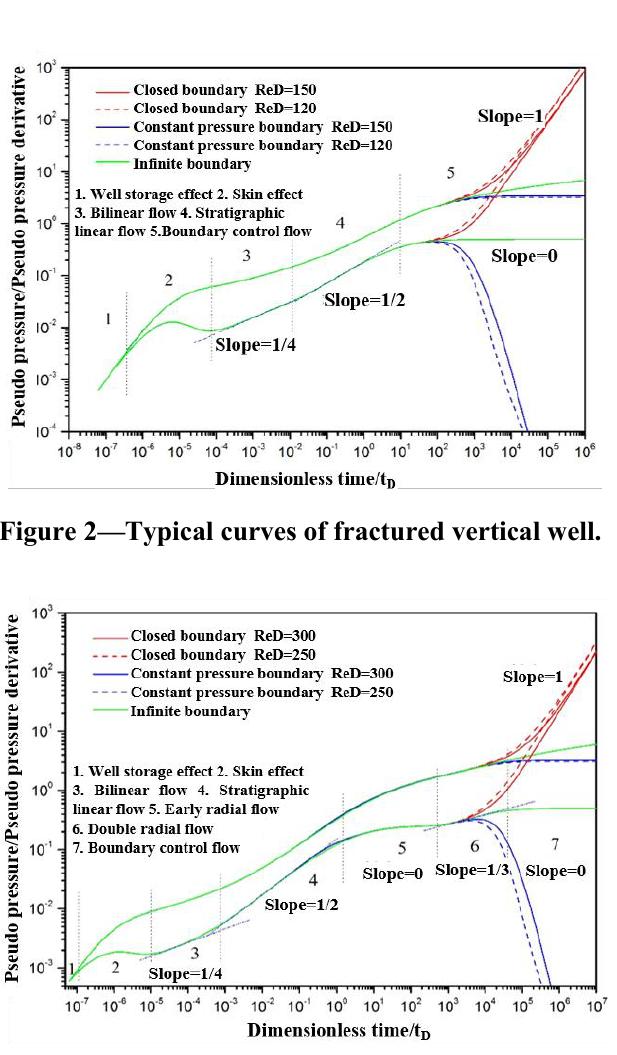
Figure 3—Typical curves of fractured horizontal well